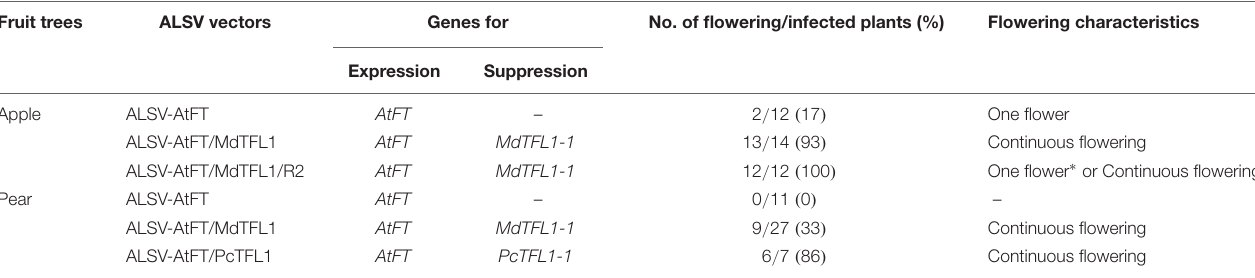
TABLE 2 | Promotion of flowering in apple and pear seedlings by infection with Apple latent spherical virus vectors. Fruit